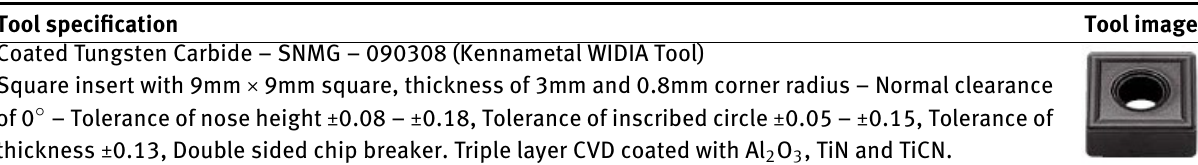
Table 2: Cutting tool inserts specifications Tool specification Tool image